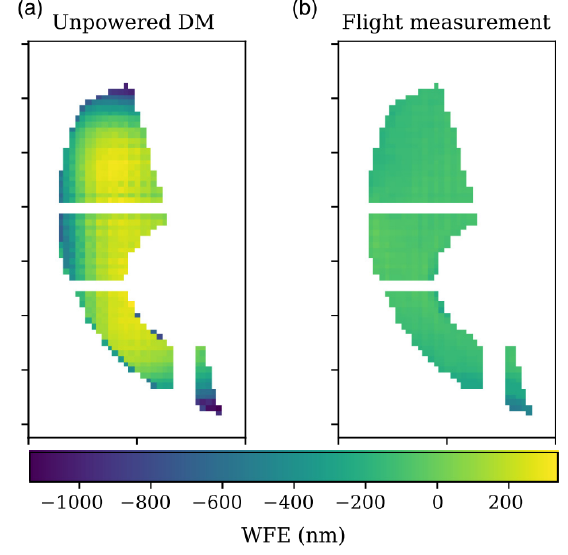
Figure 2. PICTURE-B flight measurement of the deformable mirror surface ( b ) compared to the unpowered DM profile, for the same unit, provided by BMC ( a ) demonstrates that the BMC Kilo MEMS DM was turned on and operating in the near-space environment. The median system stability measured in flight, including telescope and coronagraph wavefront errors other than tip, tilt, and piston, was 3.6 nm per pixel. Data is masked under the shearing coronagraph’s Lyot mask and for a region where wavefront sensor visibility was low. Reproduced from Douglas et al.